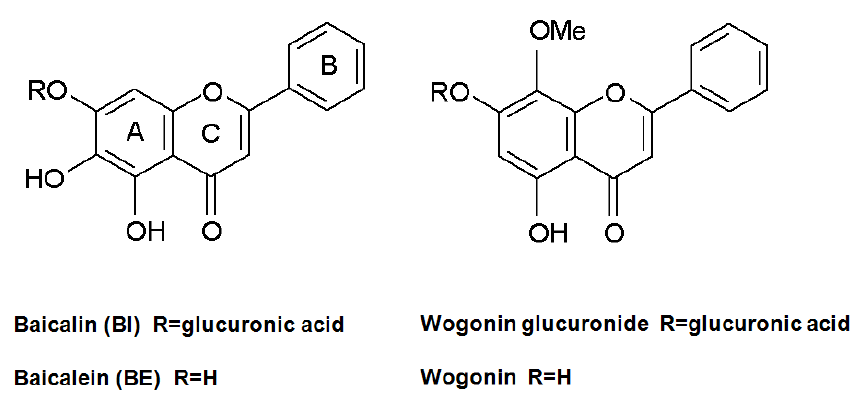
Figure 1. Structures of BI and its related